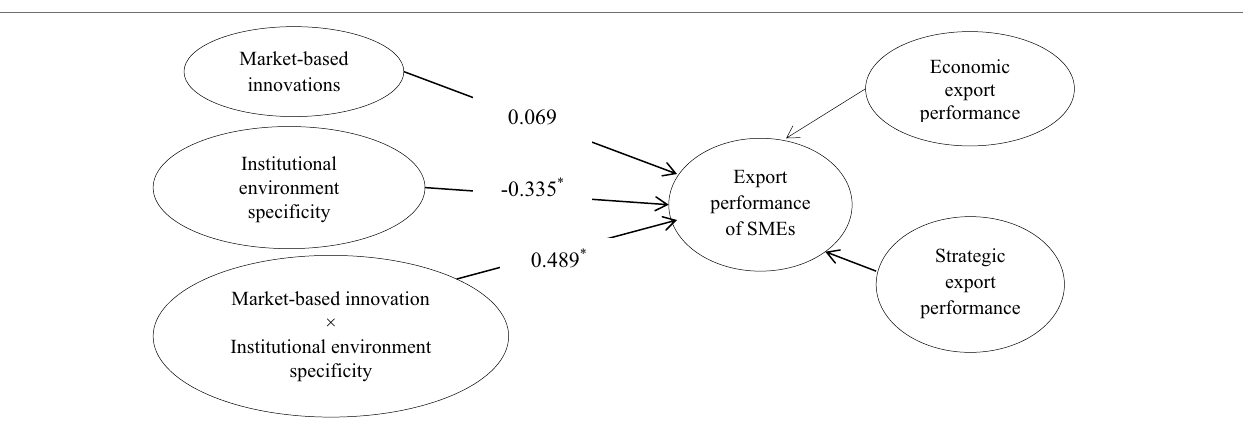
FIGURE 5 | Moderating effect of institutional environment specificity on market-based innovation–export performance link. * p < 0.05; ** p < 0.01; *** p < 0.001.